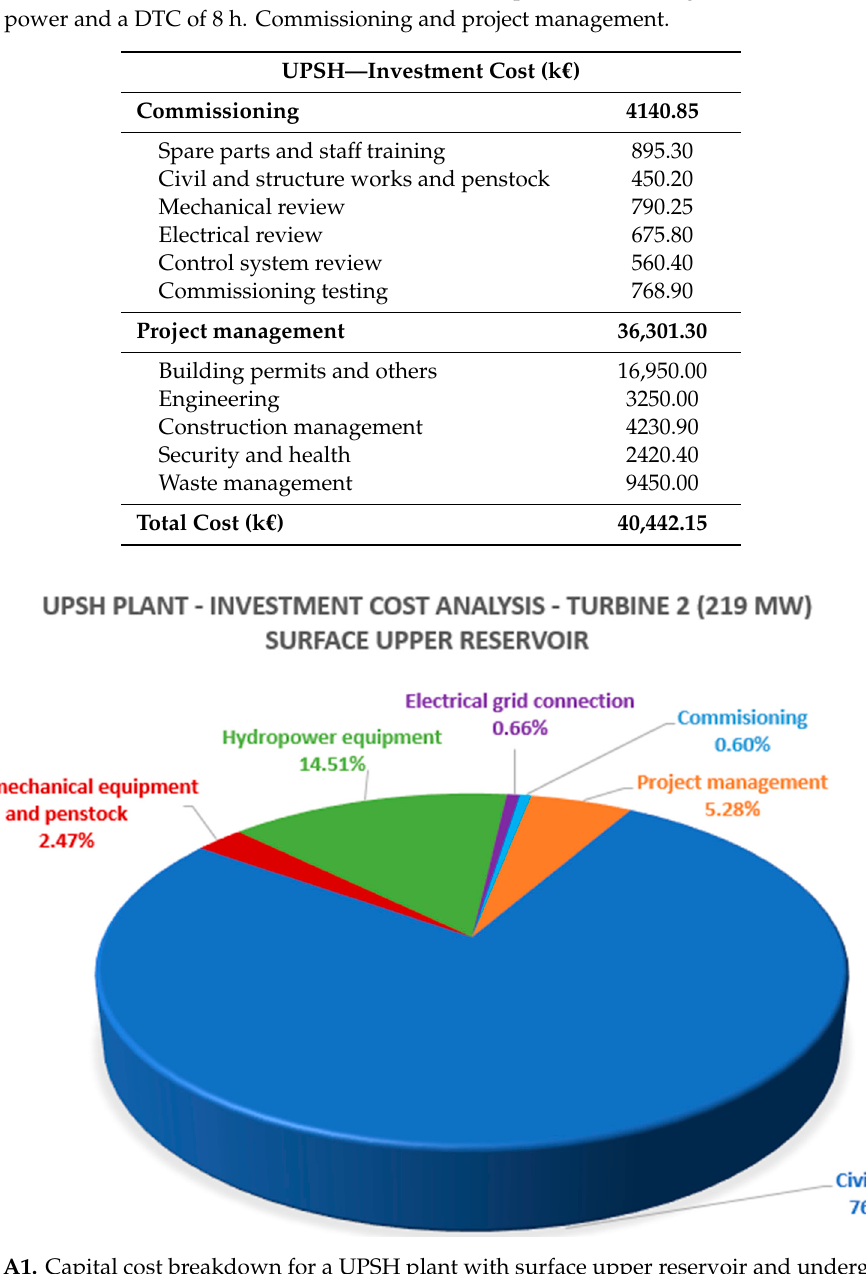
Figure A1. Capital cost breakdown for a UPSH plant with surface upper reservoir and underground lower reservoir.